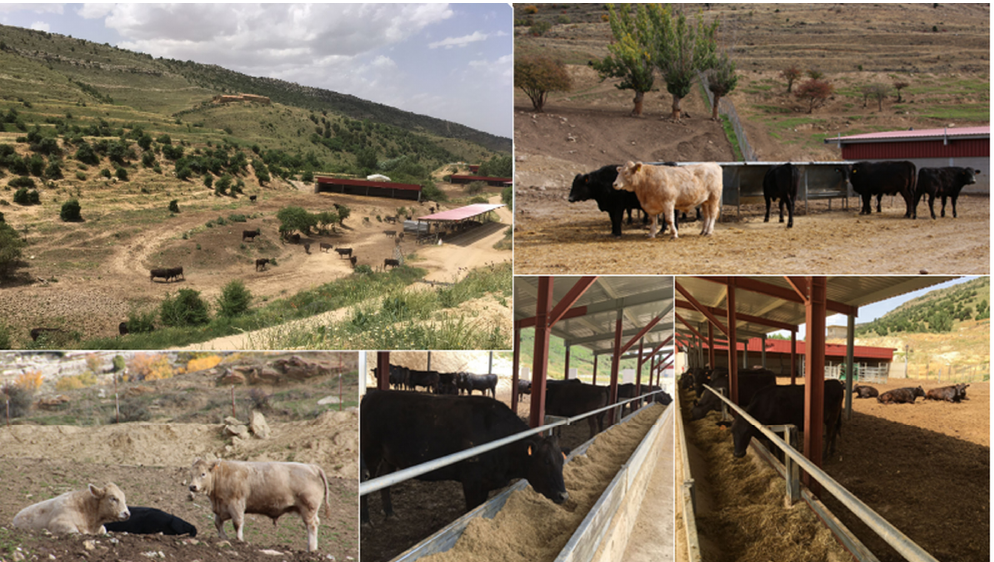
Figure 1. Fincas del Turia, Mudéjar–Wagyu farm. Purebred Wagyu steers, Wagyu-by-Angus crossbred animals (Wangus), and crossbreeds of Angus with Charolais and Limousin (ACL) are masted in open barns.